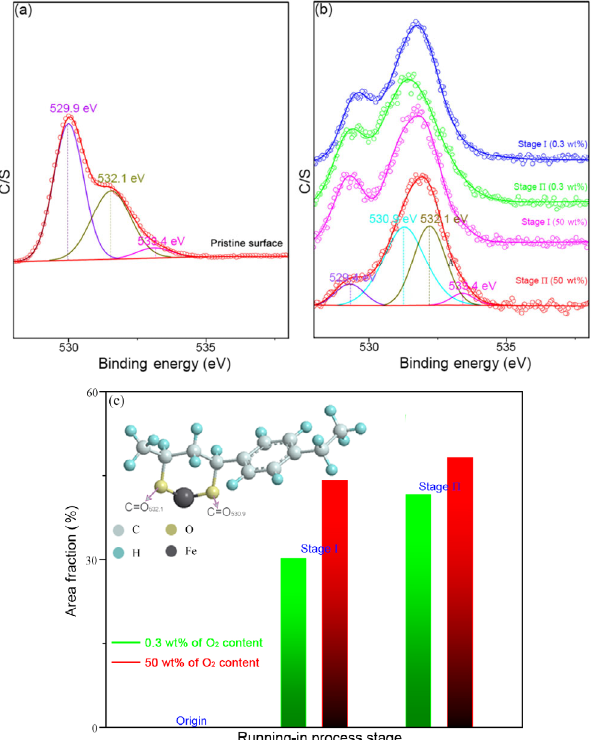
Fig. 7 XPS spectra of O 1s on (a) a pristine steel surface and inside (b) the worn tracks formed under the different conditions. (c) Area fractions of C=O bonds (530.9 eV) under different conditions. The upper-left inset in (c) schematically shows the chelated diketone molecule marked with bonding energies for C=O bond.